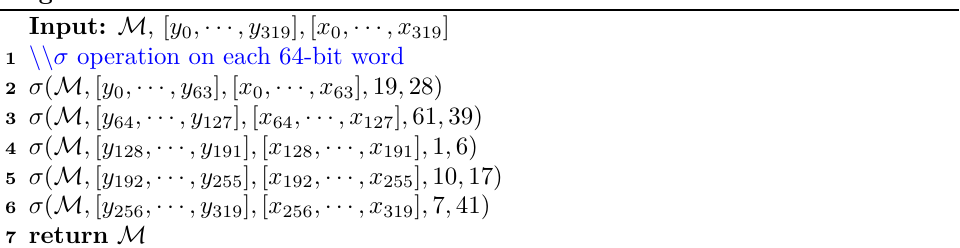
Algorithm 4: MILP model for the L function